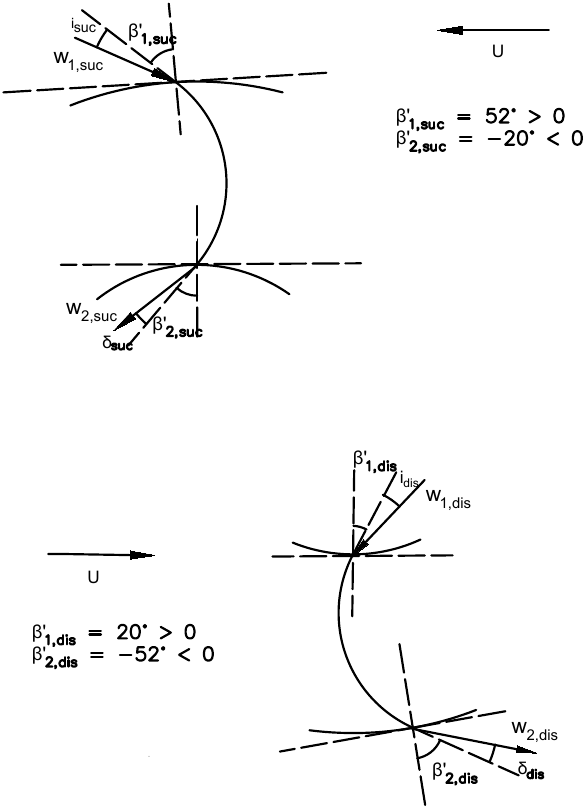
Figure 8. Air direction around blades in